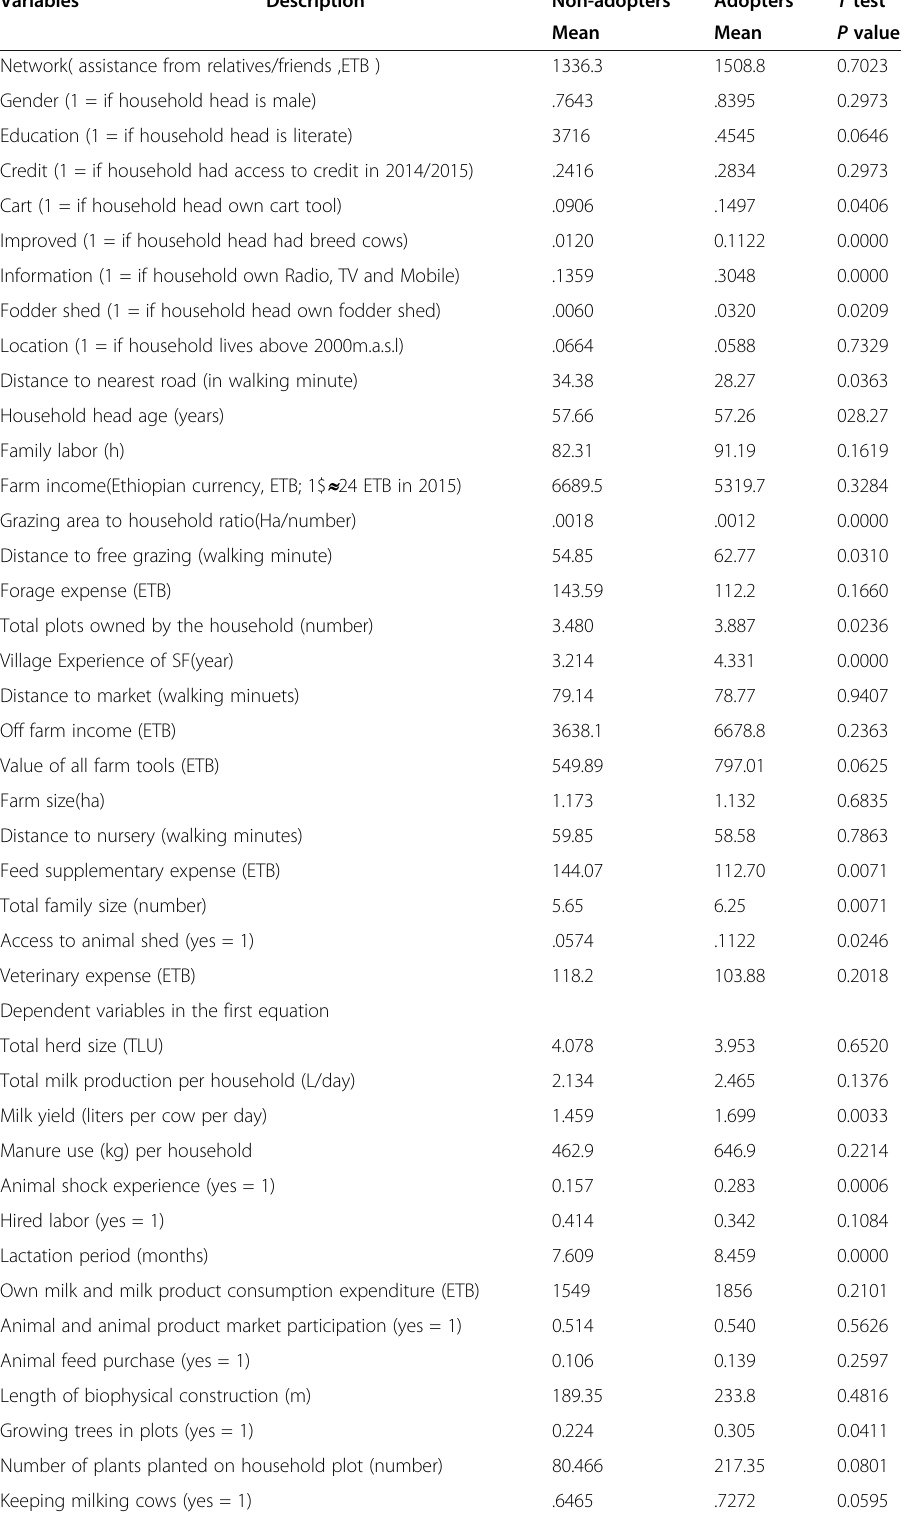
Table 1 Description and summary statistics for SF adoption decision